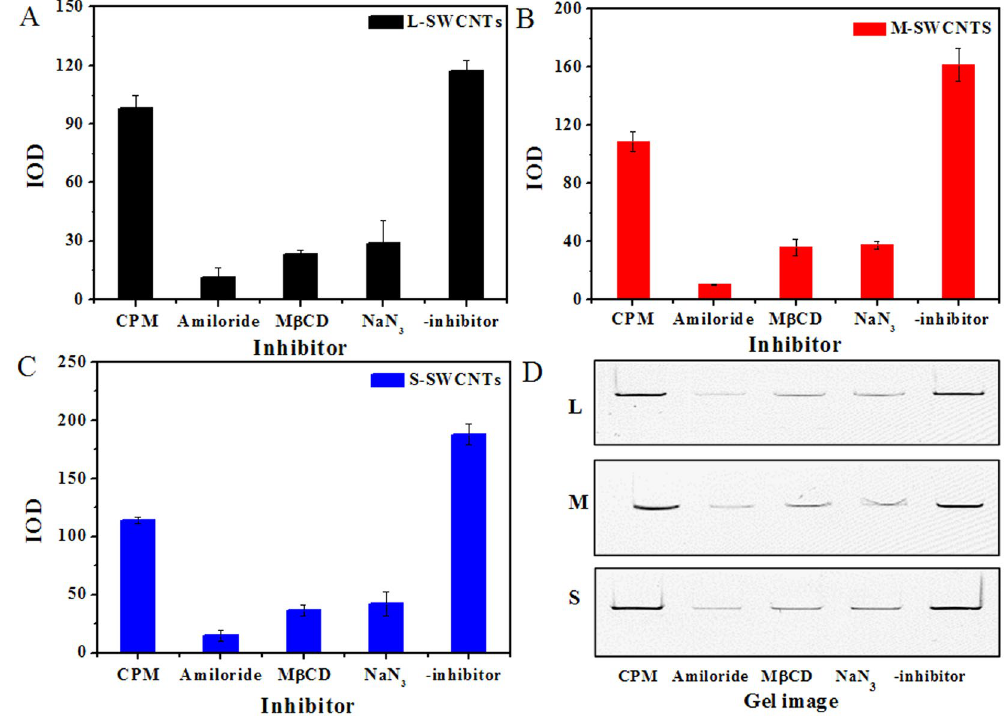
Figure 5. The inhibition of CPM, M β CD, NaN 3 , and amiloride on the endocytosis of L- ( A ), M- ( B ), and S-SWCNTs ( C ). ( D ) Typical SDS-PAGE gel images for intracellular L-, M-, and S-SWCNTs pretreated with inhibitors. The intensity of the dark band (IOD) of the SWCNTs was analyzed using Gelpro software. Data are presented as the means of three independent experiments. Error bars represent the standard error of mean.